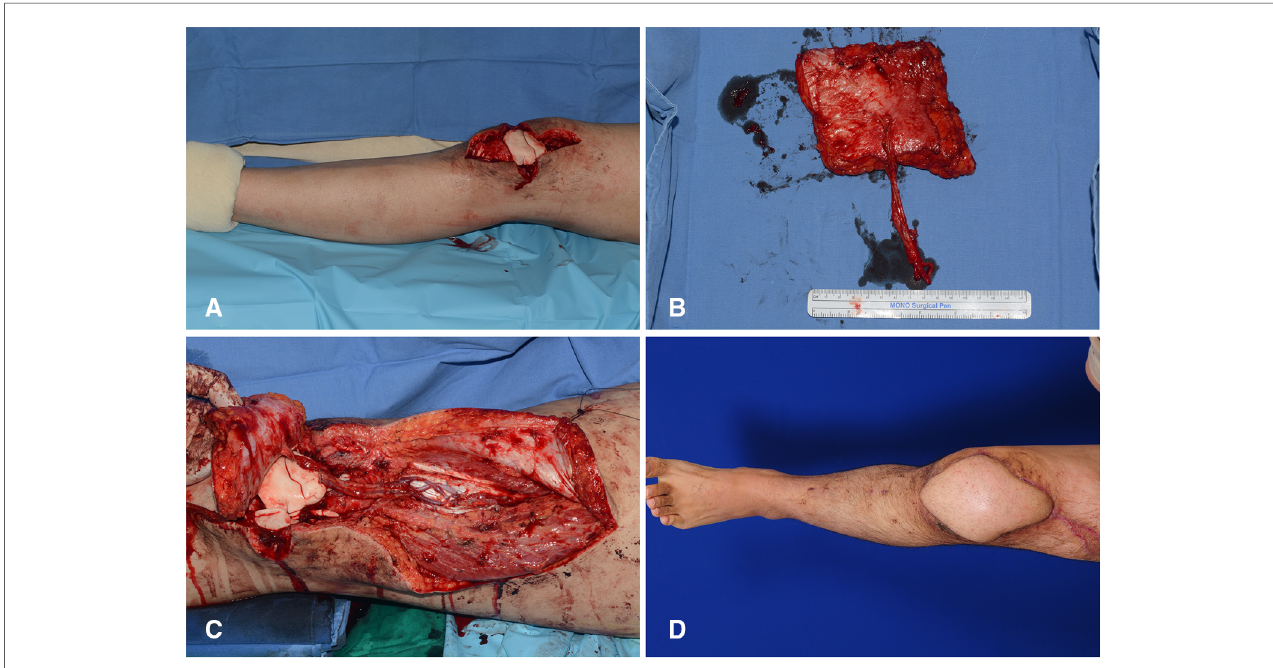
FIGURE 7 A clinical case showing the reconstruction of the soft-tissue defect around the knee using Cen-ALTP fl ap, which is anastomosed to DB-LCFA and its concomitant veins. (Case No. 5; Algorithmic option No.1) ( A ) Soft-tissue defect was created after radical debridement of the knee joint in a 24-year-old male patient with chronic osteomyelitis. The defect center was above the patella center. ( B ) Because the defect size was relatively small, Cen-ALTP fl ap with small round skin paddle (16×14 cm2) was harvested. ( C ) The fl ap pedicle was anastomosed to DB-LCFA and its concomitant veins. ( D ) Result 5 months postoperatively. (Cen-ALTP fl ap, anterolateral thigh perforator fl ap with centrally located perforators; DB-LCFA, descending branch of the lateral circum fl ex femoral